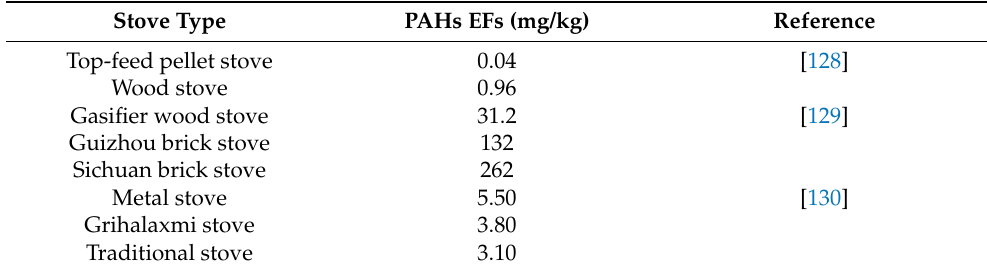
Table 11. Emission factors of PAHs of the same biomass burning in different stoves.